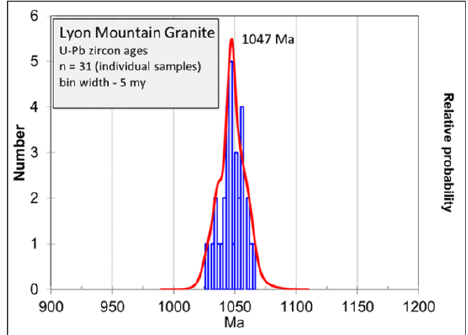
Figure 10. Histogram showing U-Pb zircon ages of Lyon Mountain Granite samples previously analyzed. Data from References [12,13,34,36,40,42].